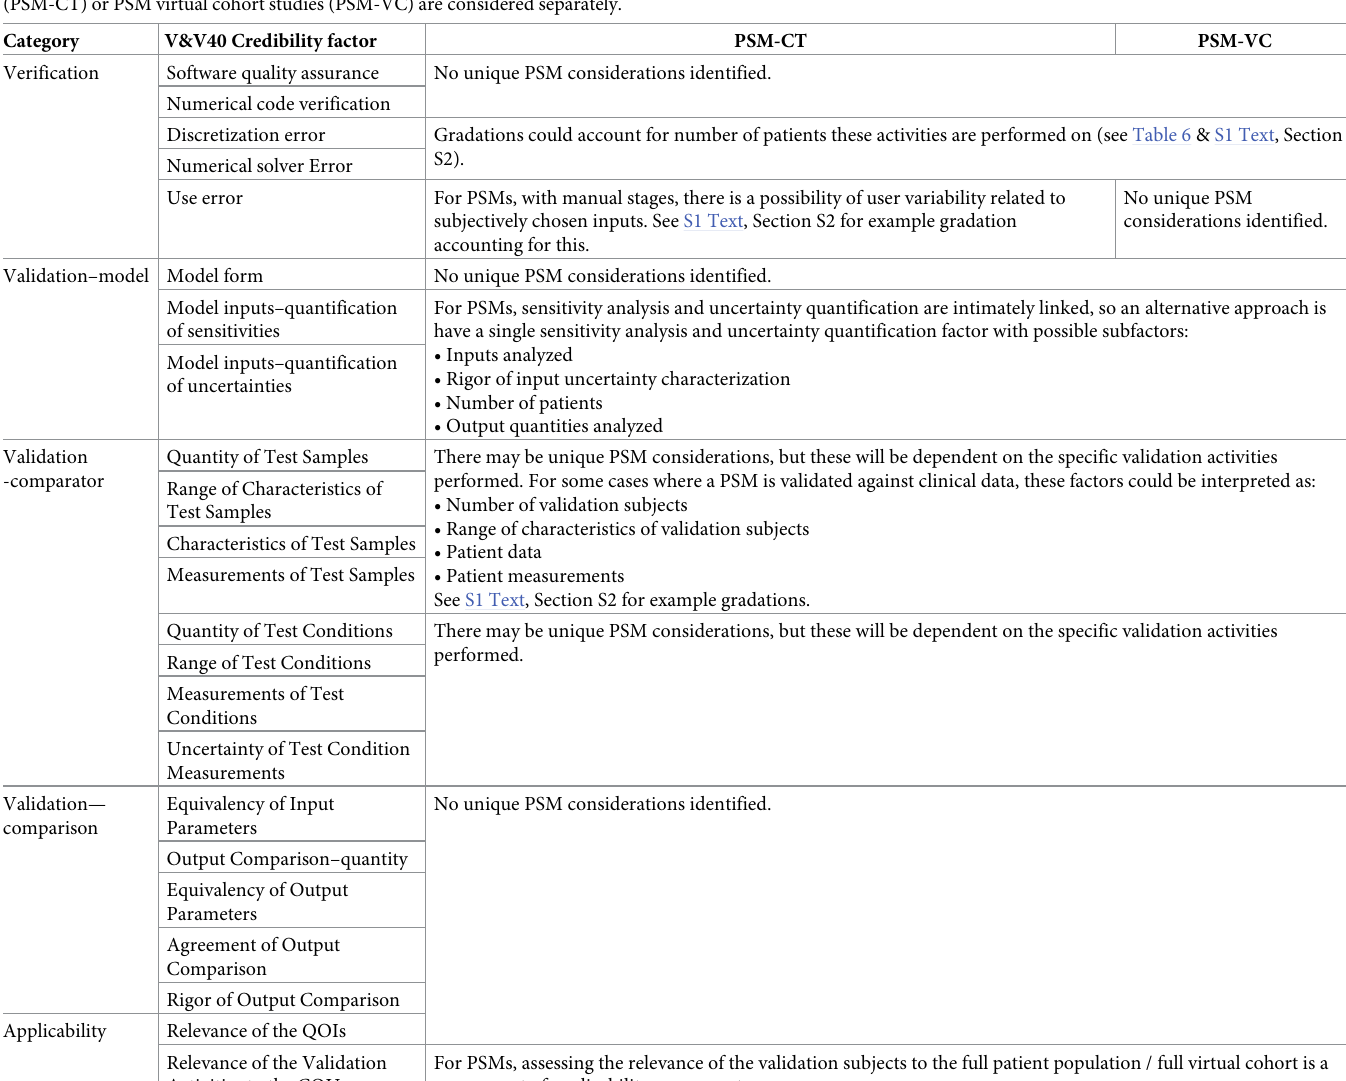
Table 5. Summary of observations on considerations for PSM credibility assessment in relation to V&V40 credibility factors and gradations. PSMs as clinical tools (PSM-CT) or PSM virtual cohort studies (PSM-VC) are considered